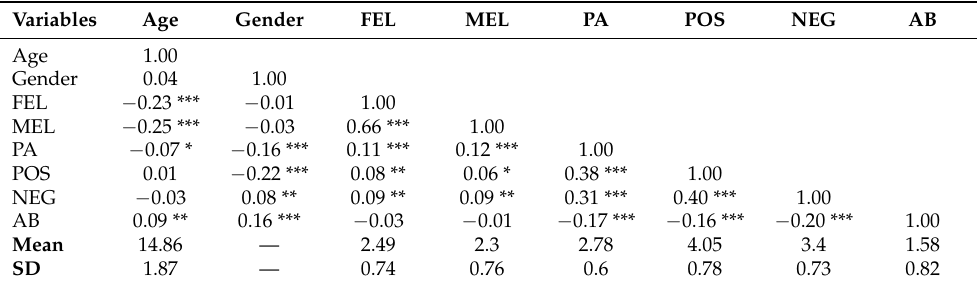
Table 3. Means, standard deviations, correlations, and reliabilities among the variables.